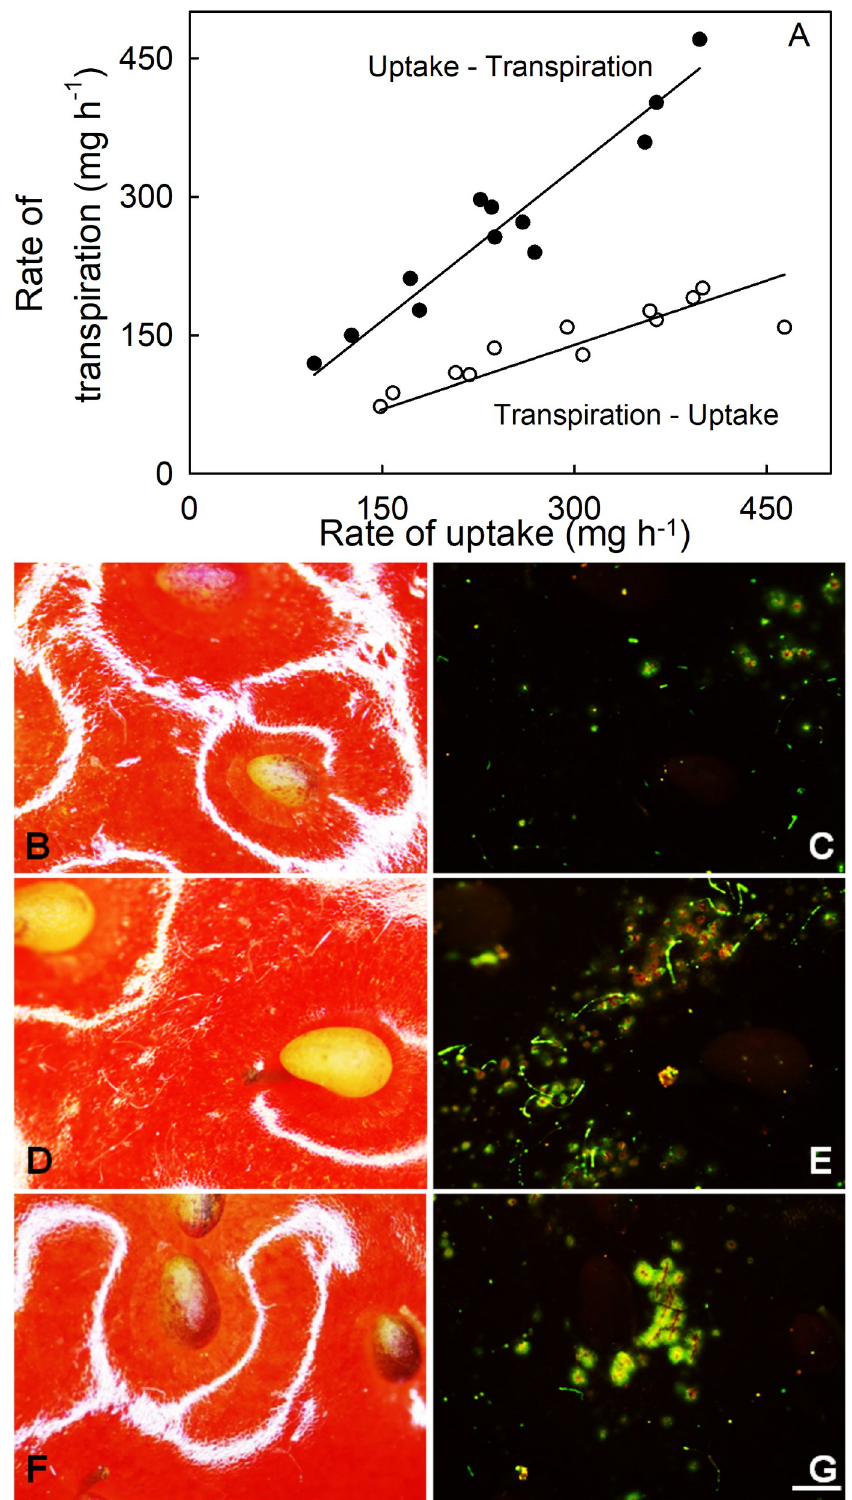
Fig 9. Effect of sequence when determining both water uptake and transpiration on water movement and on formation of microcracks. (A) Relationship between rate of osmotic uptake (F f ,) and rate of transpiration (F t ) for fruit subjected to the osmotic uptake determination first, followed by transpiration (‘uptake ! transpiration’) and vice-versa